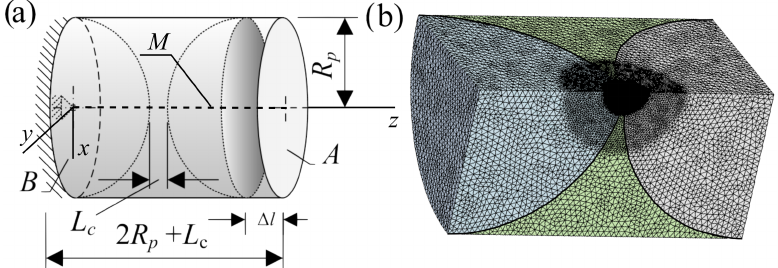
Figure 4. Geometry of the sample under investigation: a scheme of the connecting element ( a ), and its discretization by the tetrahedron elements “SOLID187” ( b